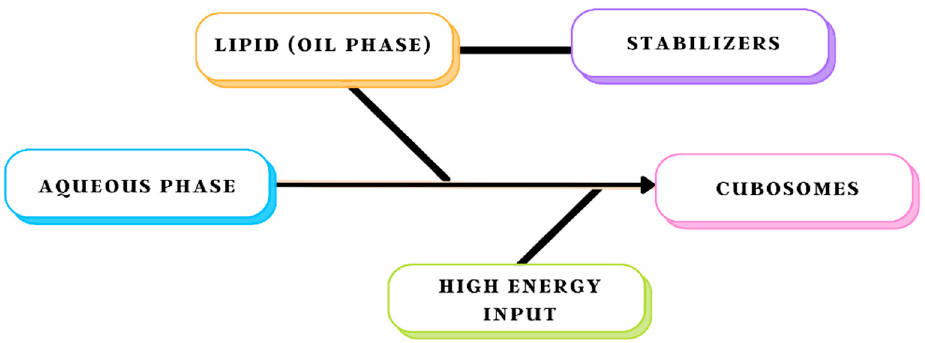
Figure 3. Schematic representation of the top-down approach method.